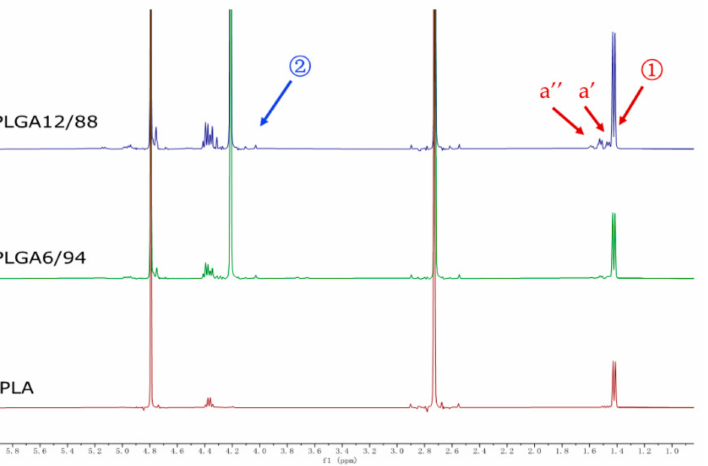
Figure 4. 1 H NMR spectra of PLGA 12/88, PLGA 6/94, and PLA hydrolysis in D 2 O with 2.0 mg dimethyl sulfoxide as internal standard in 45